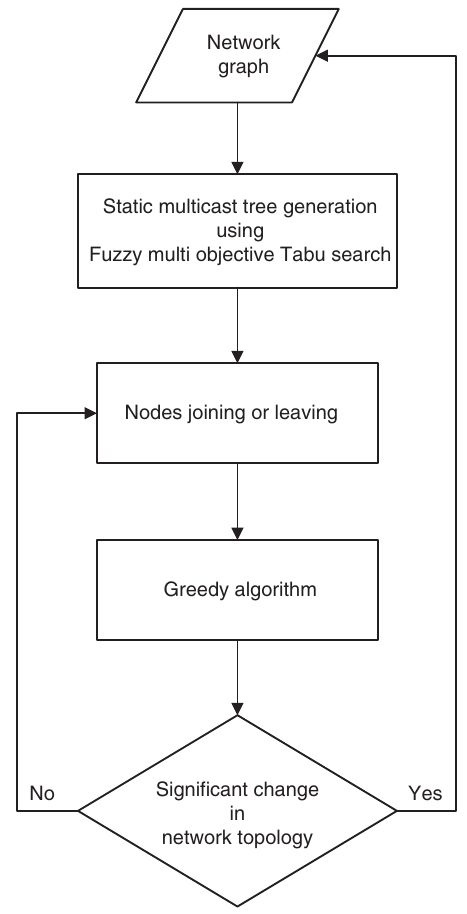
Figure 1. Proposed System for Dynamic Multicast Tree